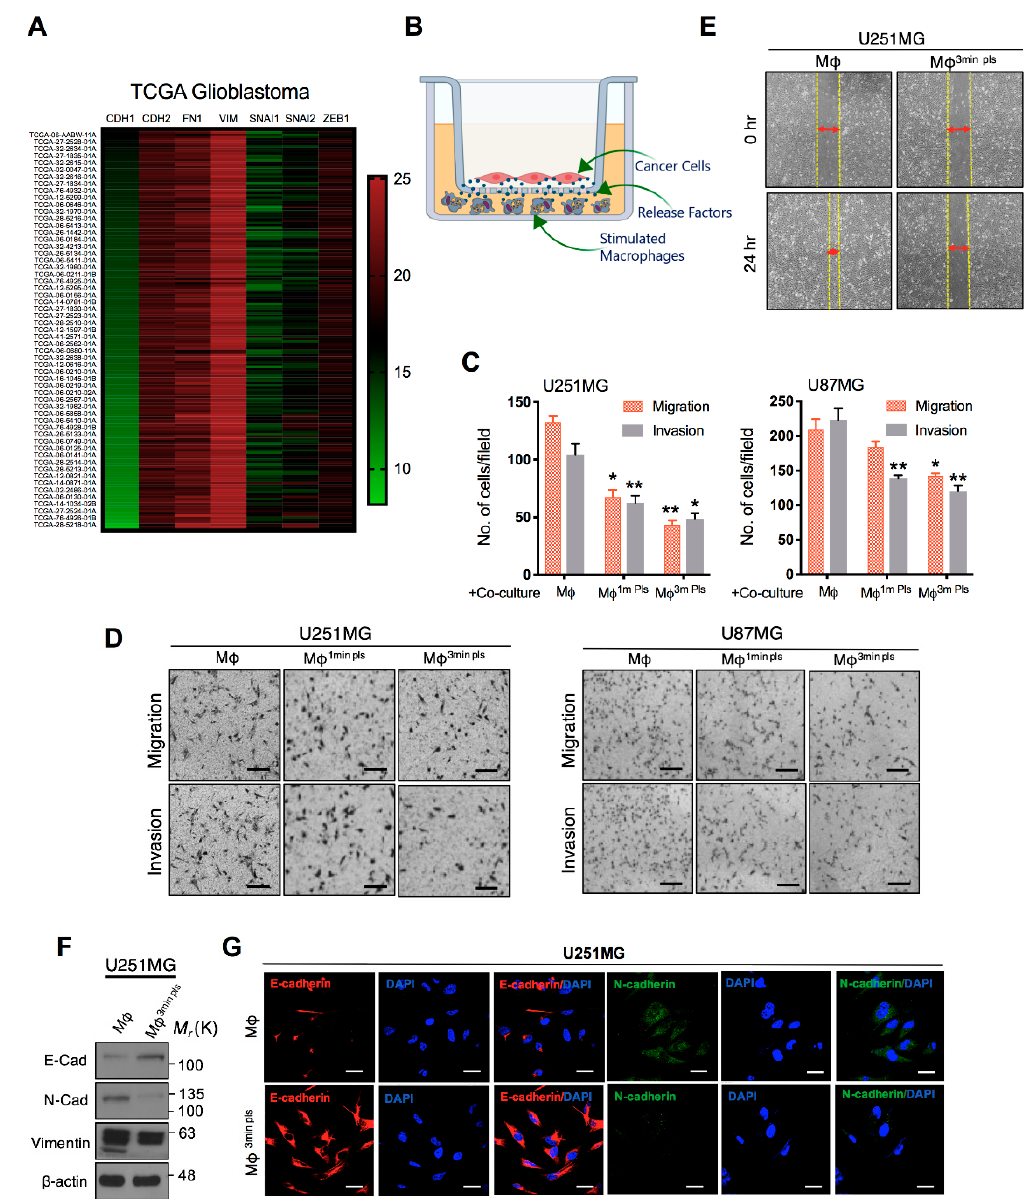
Figure 5. Analysis of the epithelial-mesenchymal transition in glioma cells after macrophage-cancer cell co-culture. ( A ) UCSC Genome Browser showing the expression of EMT signature genes in glioblastoma extracted from TCGA database. ( B ) Schematic diagram for tumor-macrophage cell co-culture and conditioned as mentioned in Figure 3. ( C , D ) Bar graph and representative images of the Transwell assays for migration and invasion in U251MG and U87MG brain cancer cells 48 h after co-culture treatment, Scale bar = 100 µm. The bar graph shows the number of cells selected from three independent fields of each group. ( E ) Wound-healing (Scratch assay) assay to analyze the migration of U251MG cells after co-culture in a similar condition. ( F ) Immunoblotting for EMT-indicative markers in glioma cells after co-culture with control and 3-min plasma-stimulated macrophages. ( G ) Confocal images of E-cadherin and N-cadherin expression in glioma cells after co-culture, scale bar = 10 µm. Error bars represent the mean ± S.D. of triplicate samples. * p < 0.05 and ** p < 0.01.